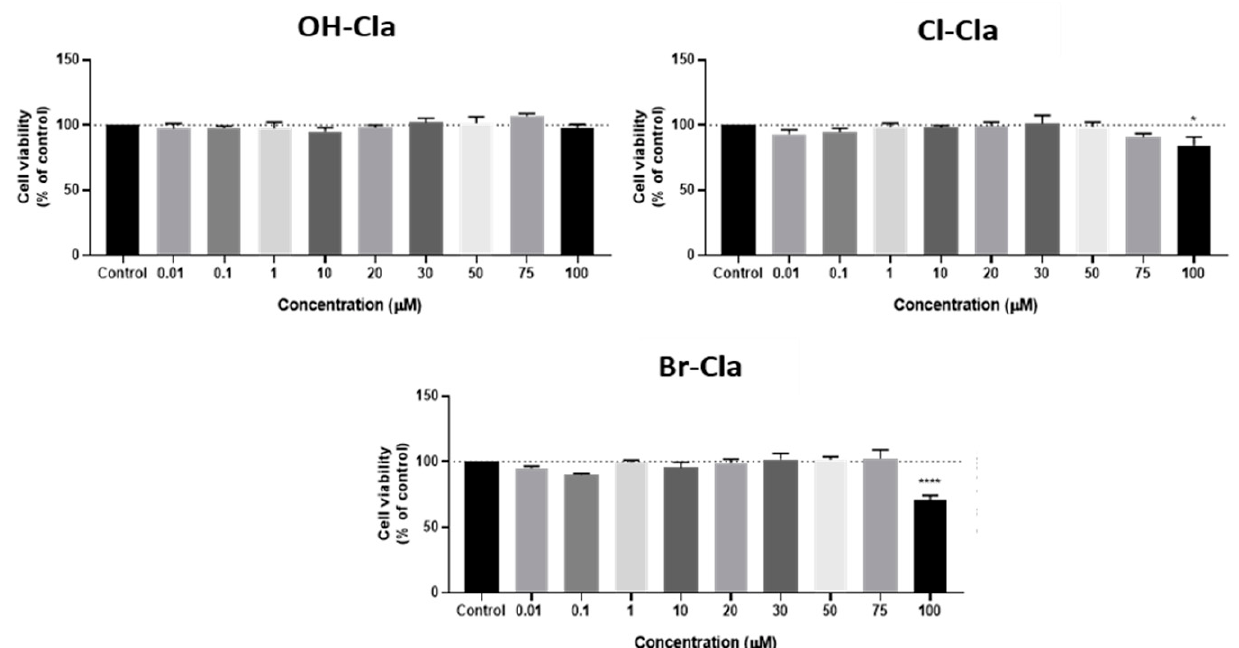
Figure 4. Effect of OH-, Cl-, and Br-Cla on HT-29 cell viability. Cells were cultured in the presence of increasing concentrations of each compound. After 48 h, an MTT assay was performed to measured cellular viability. Results are presented as mean ± SEM. * Statistically significant vs. control at p < 0.05; **** statistically significant vs. control at p < 0.0001.